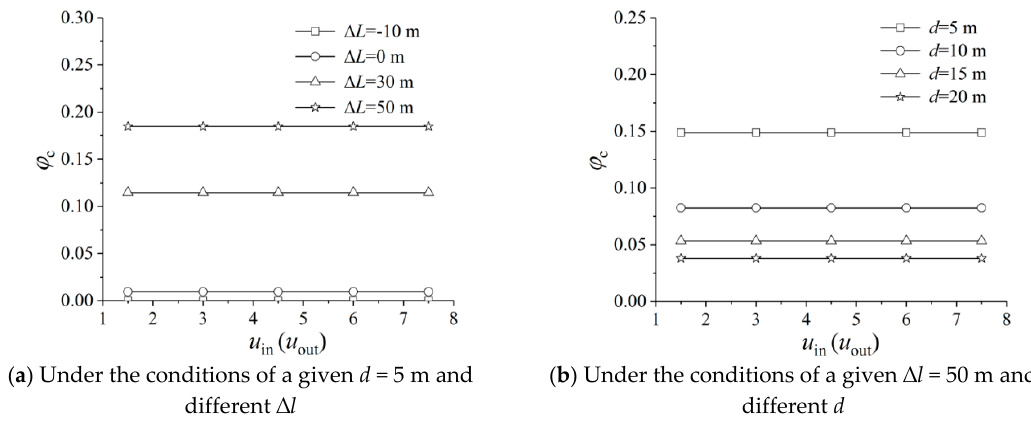
Figure 10. Impacts of air velocity u on circulating air mixing ratio φ c .